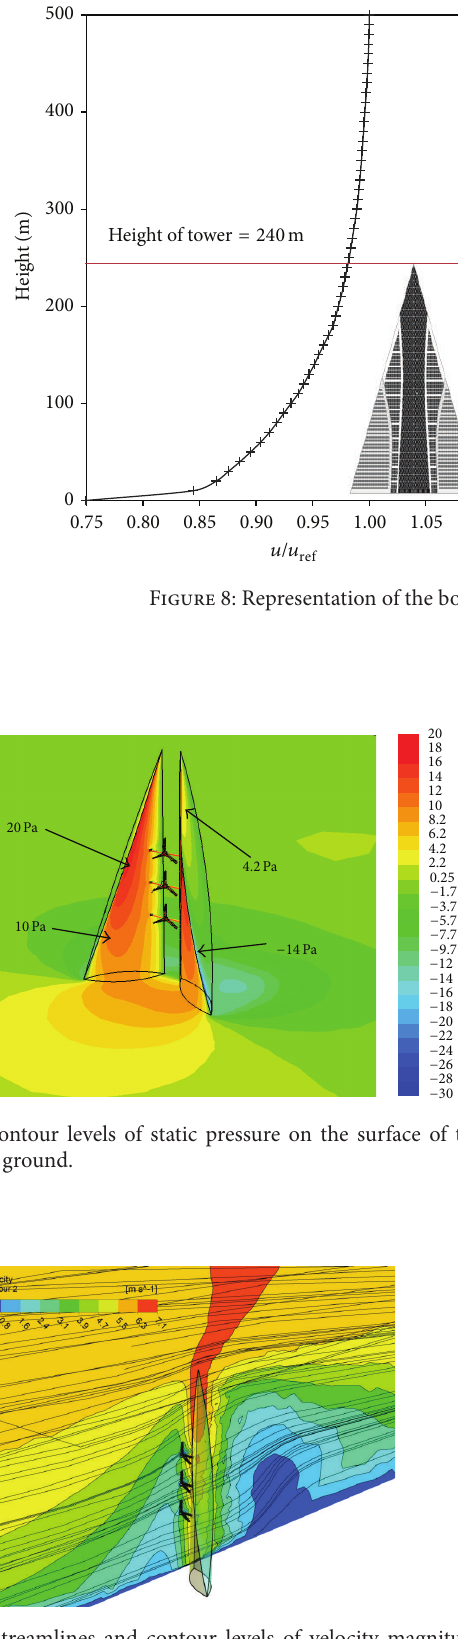
Figure 10: Streamlines and contour levels of velocity magnitude formation upstream and downstream of the building.